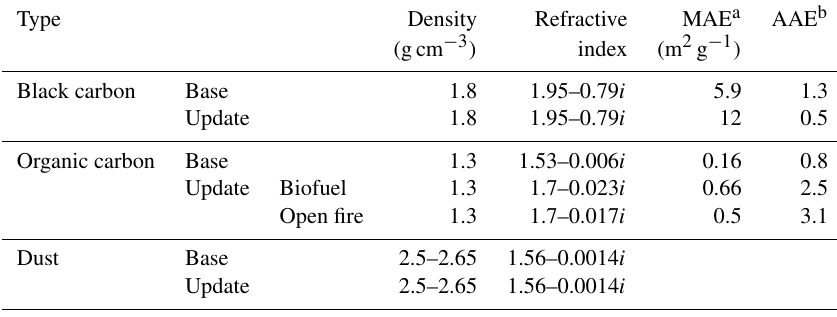
Table 1. Optical properties of light-absorbing aerosol at 550nm in GEOS-Chem. Type Density